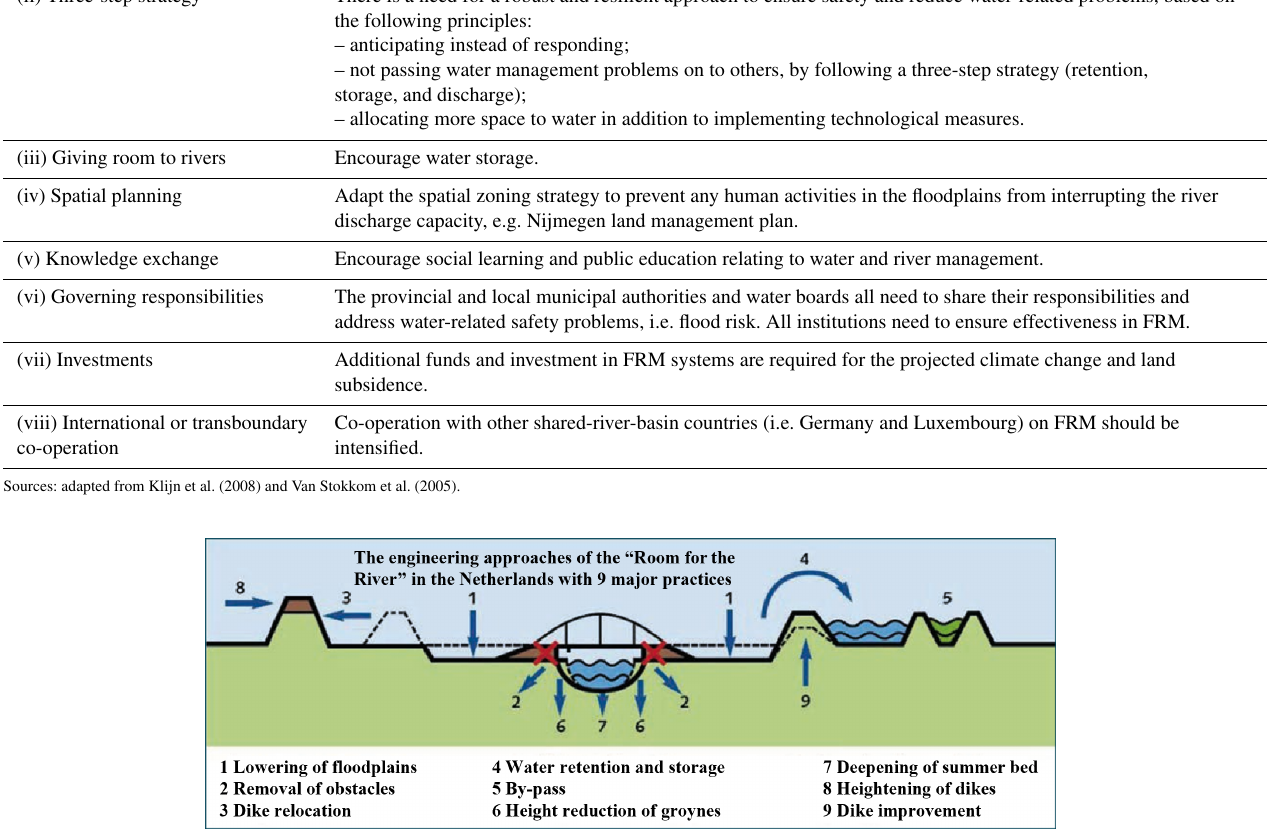
Figure 1. Measures of Room for the River in the Netherlands. Source: Room for the River programme